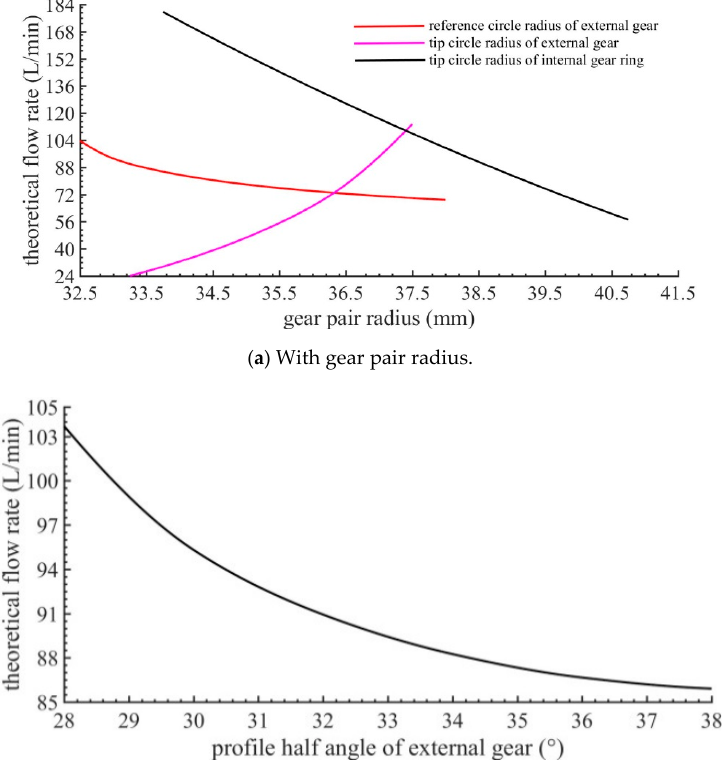
Figure 7. Change laws of the theoretical flow rate.